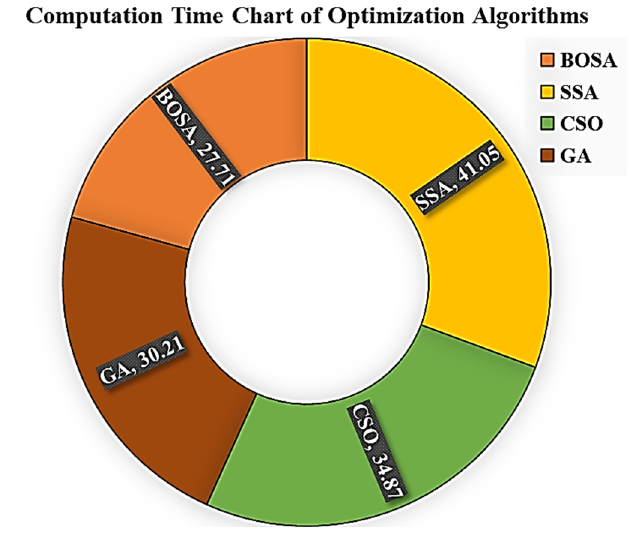
Figure 13. Elapsed times of the optimization algorithms in seconds.